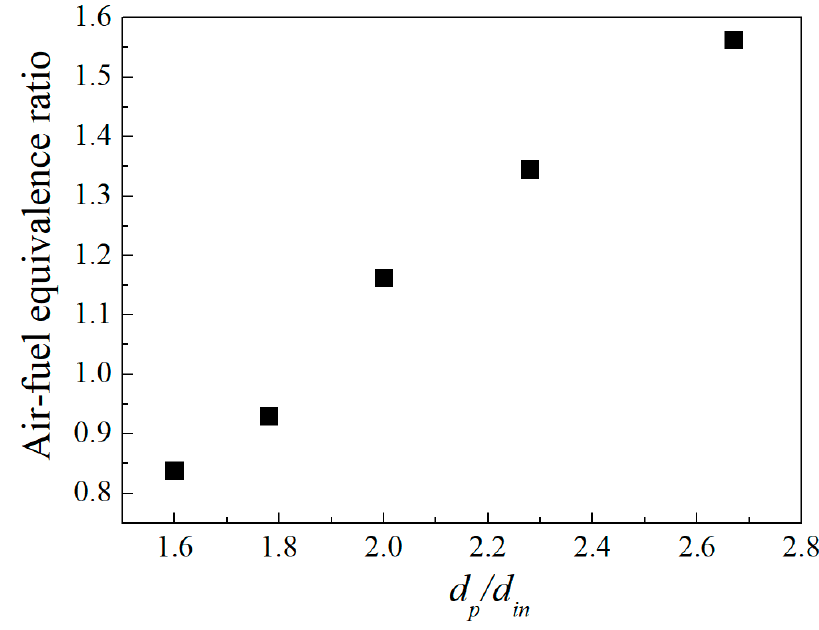
Figure 34. The regression rate for different sudden expansion ratio with d p fixed as constant.